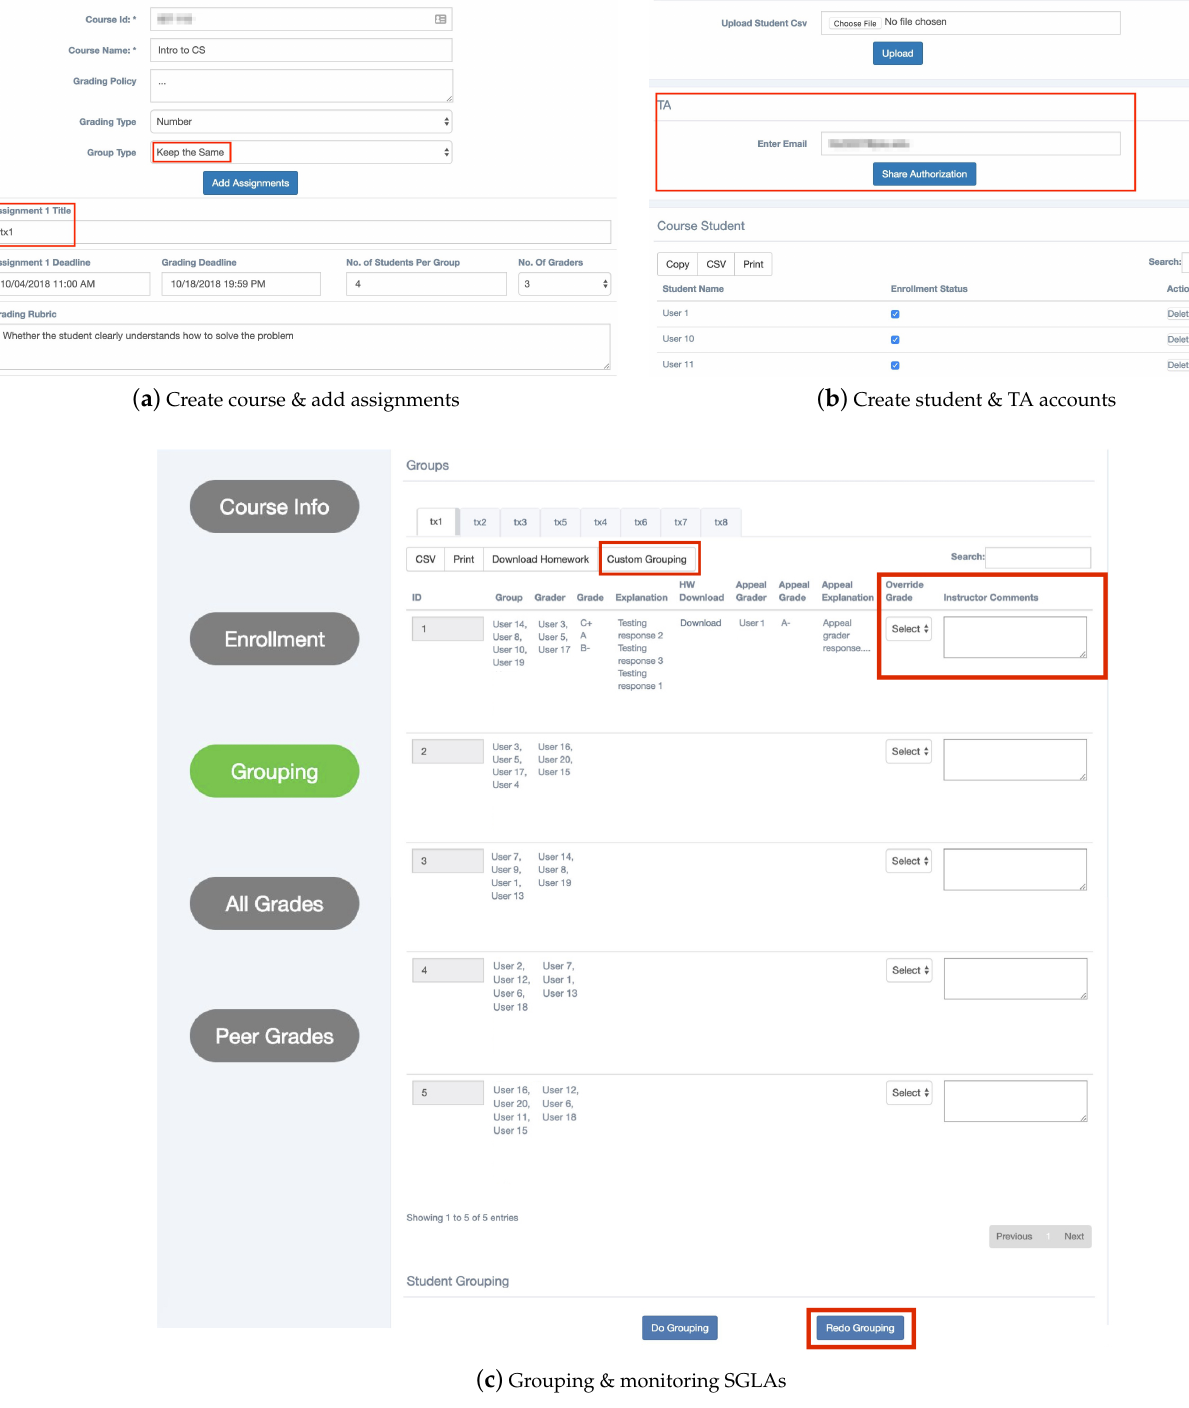
Figure 1. Finalized instructor user interface. Note that system updates are boxed with